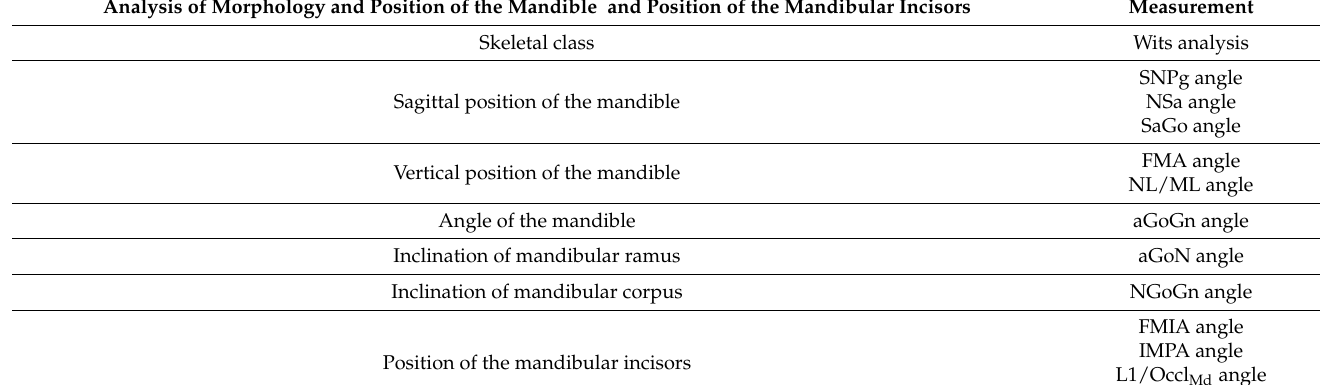
Table 3. List of different cephalometric measurements used for the analysis of: skeletal class, sagittal and vertical position of the mandible, angle of the mandible, inclination of the mandibular ramus and the mandibular corpus, as well as for the analysis of the mandibular incisors position.